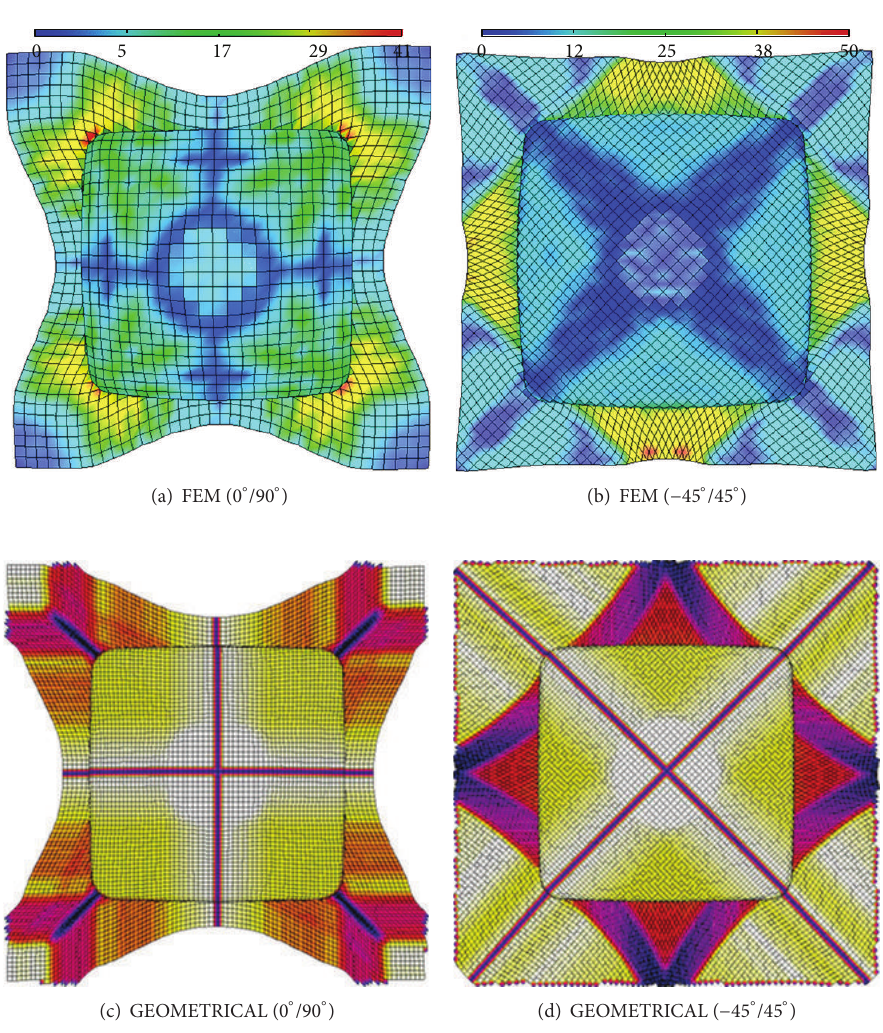
F 18: Geometrical and FE predicted results